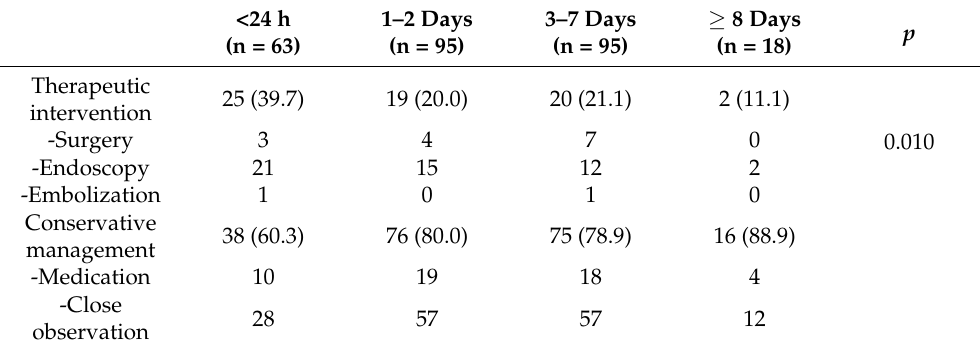
Table 3. Management of patients with overt obscure gastrointestinal bleeding according to the duration between bleeding and video capsule endoscopy.